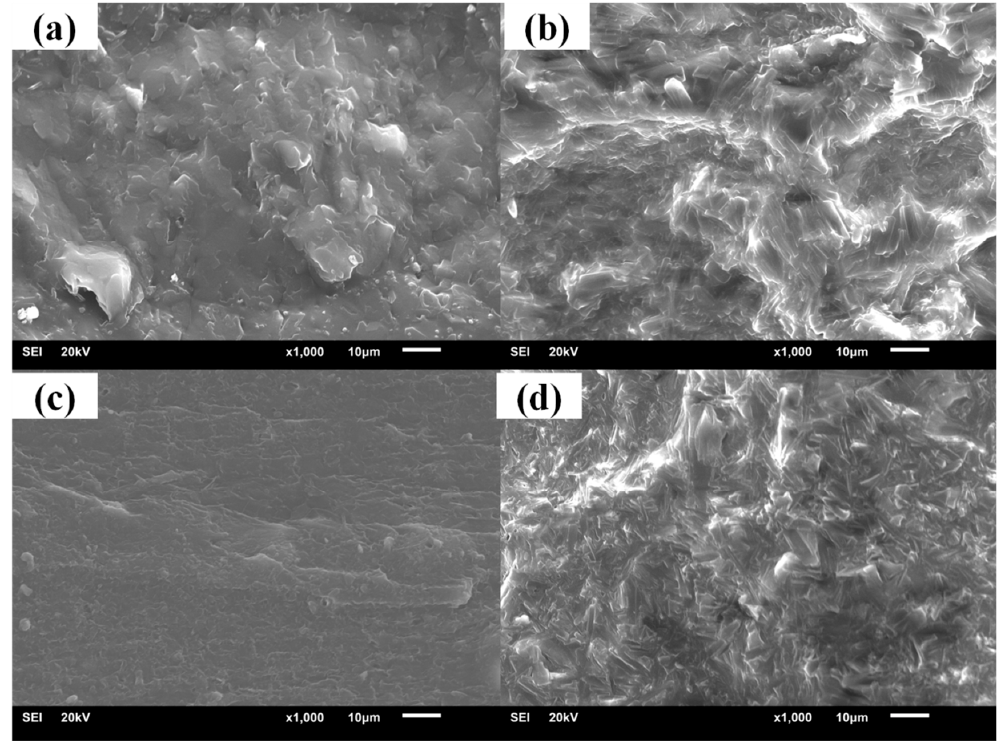
Figure 10. SEM patterns of XNBR/XH-245 before and after thermal aging: ( a ) XNBR/XH-245(20); ( b ) XNBR/XH-245(20) after aging; ( c ) XNBR/XH-245(60); ( d ) XNBR/XH-245(60) after aging.